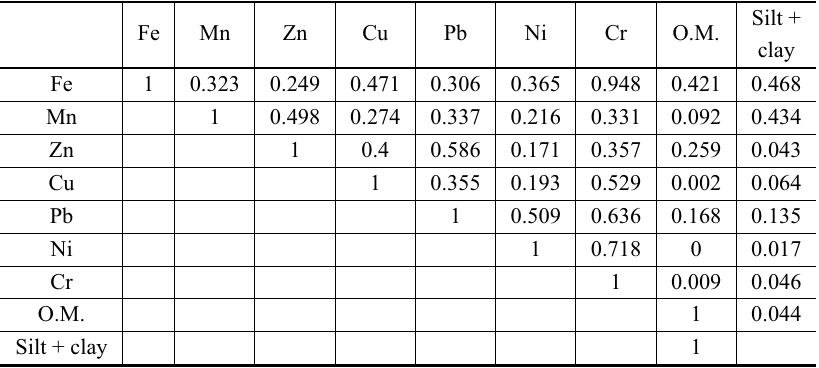
Pearson correlation coefficient matrix for heavy metals in the urban street sediments ( < 63 mm) from the road around Guanabara Bay. Fe